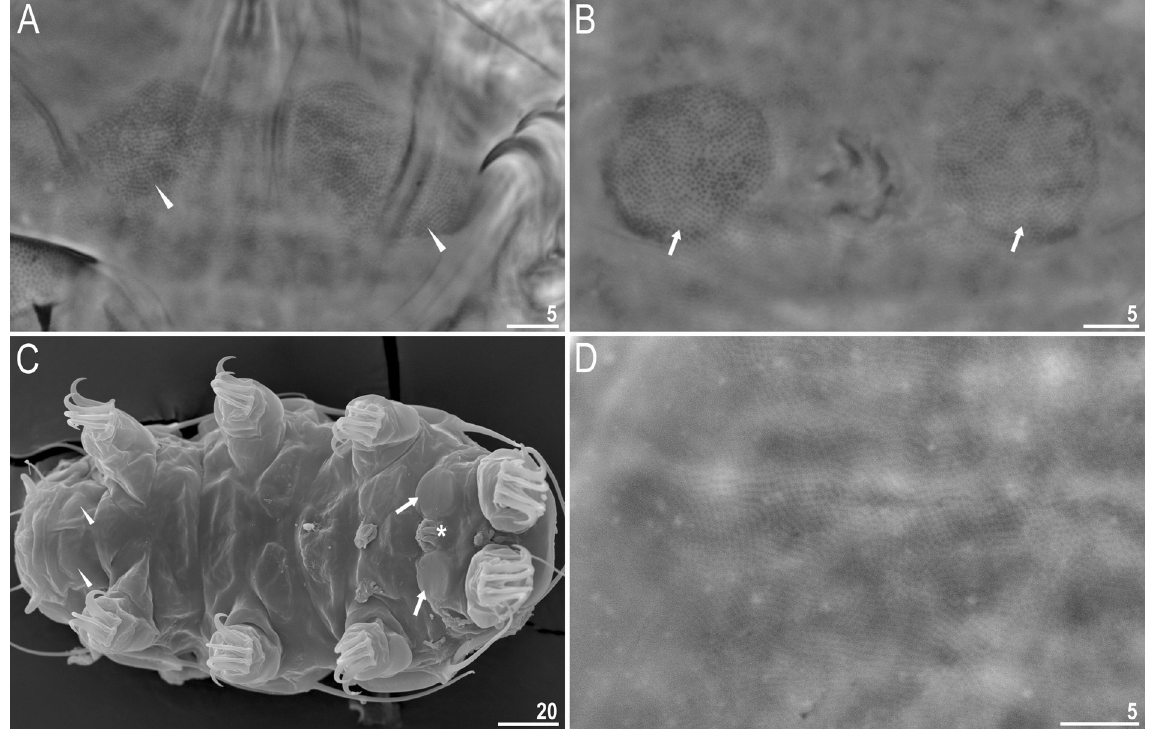
Fig. 3. Echiniscus quadrispinosus Richters, 1902, ♀. A . Two ventral plates below the head, arrowheads (PCM). B . Two ventral rounded plates on the lateral sides of the gonopore, arrows (PCM). C . Lateral view of the entire animal; arrowheads indicate plates below the head; arrows indicate plates on the lateral sided of the gonopore; asterisk indicates gonopore (SEM). D . Ventral sculpture visible in PCM. Scale bars in micrometres